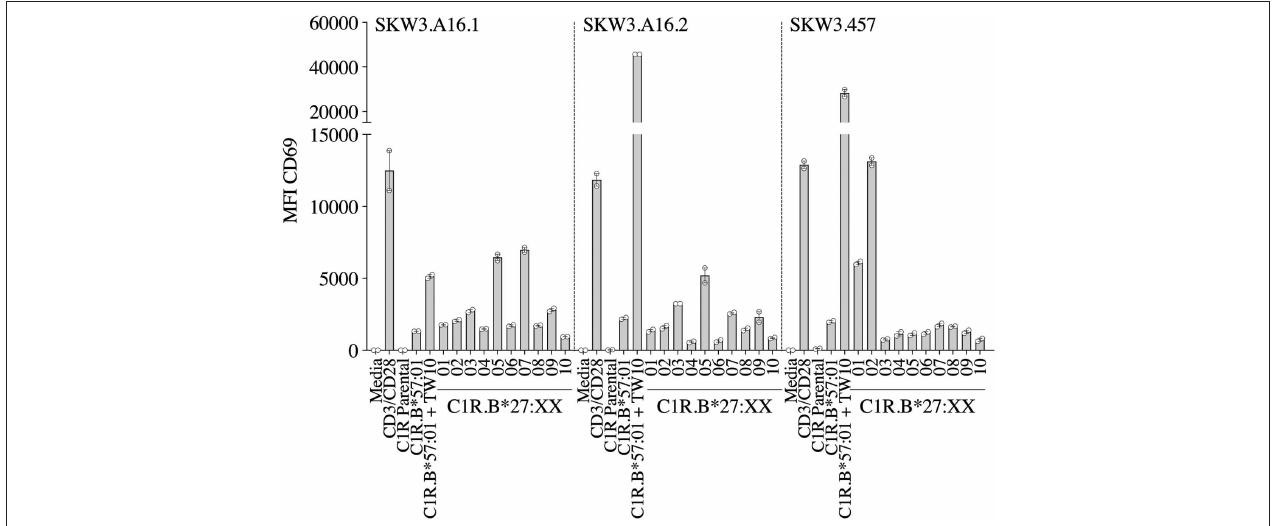
FIGURE 5 | HIV-1 B57 TW10 allorecognition of HLA-B27 molecules. TCR activation was measured using cell surface CD69 upregulation after 16–20h stimulation with C1R.B*57:01 ± cognate TW10 peptide and a panel of C1R.B27 transfectants. CD69 MFI values were calculated after gating on FSC vs. SSC, single cells, GFP + cells, live cells, CD3 + CD8 + cells then CD69 + cells. Mean ± SEM are shown (a single experiment with duplicate data is shown from independent biological replicates performed at least